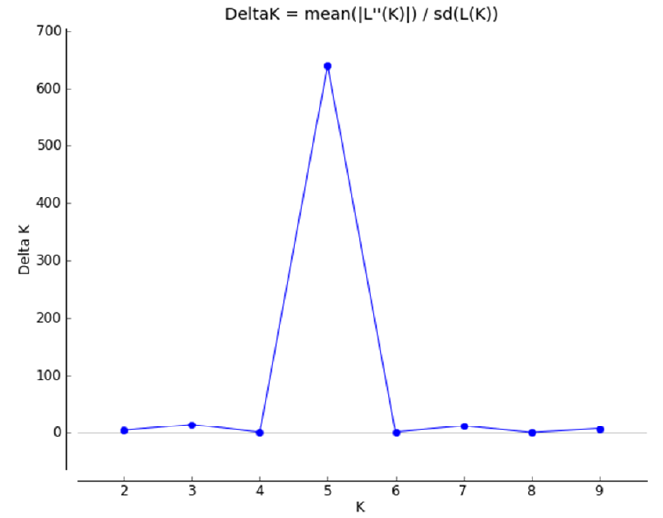
Figure 4. Plot of delta K calculated as the mean of the second-order rate of change in the likelihood of K divided by the standard deviation of the likelihood of K, m(|L ” (K)|)/sd[L(K)]. Delta K = 5 is the potential number of genetic clusters that may exist in the overall sample of individuals.